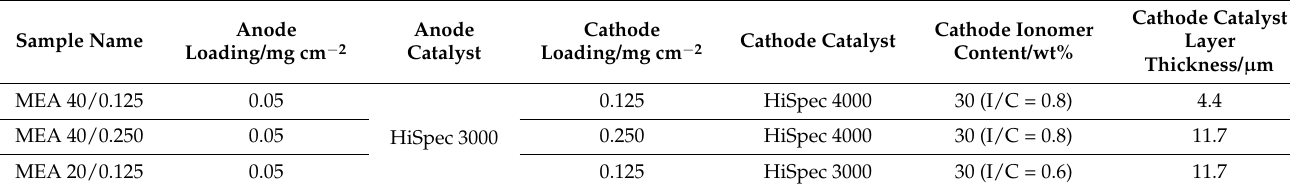
Table 1. List of prepared membrane electrode assemblies (MEA). Catalyst-layer thickness was determined by cross sectional SEM